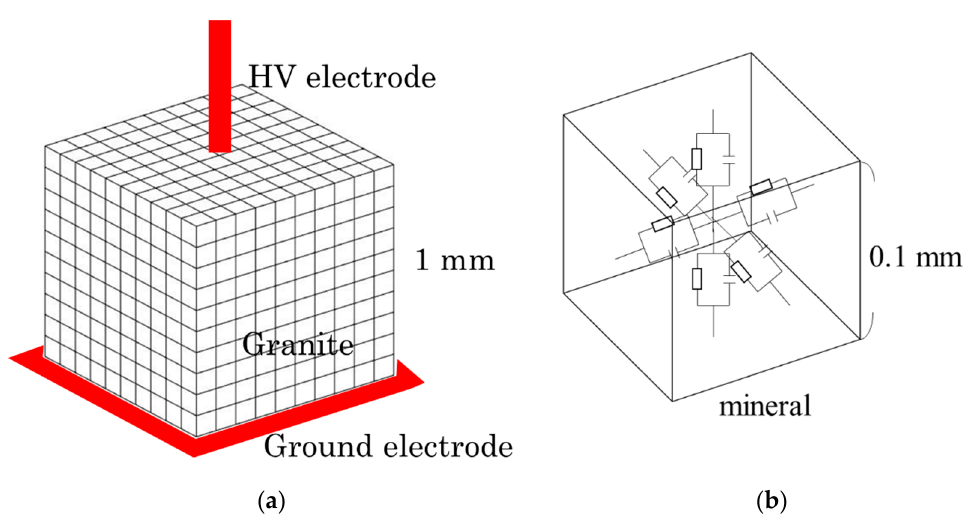
Figure 2. Concept of equivalent circuit model. ( a ) Granite; ( b ) equivalent circuit model for a small divided cube of granite.